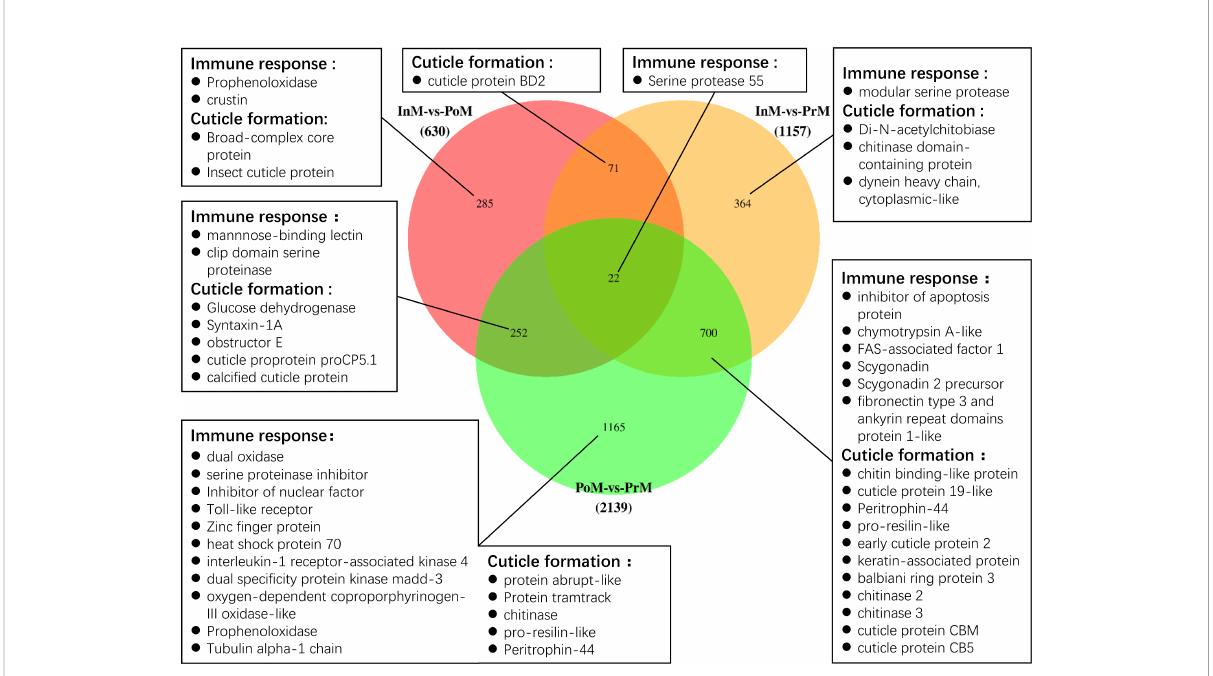
FIGURE 3 Venn diagram of the DEGs among three molting stages. The numbers of the unique and common DEGs are indicated. The genes related to immune response and cuticle formation have been